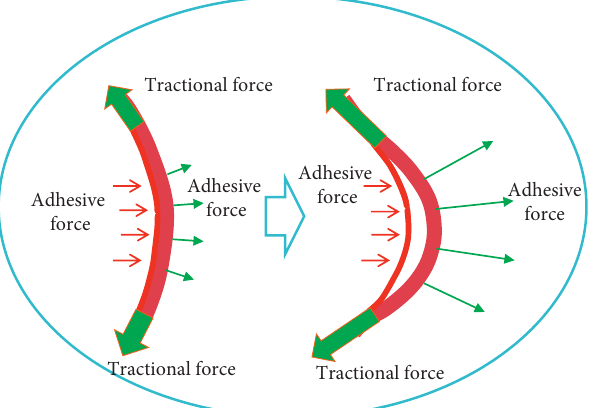
Figure 3: Possible mechanism of force in patients with myopic foveoschisis. The image on the left belongs to a nonmyopic patient. The image on the right belongs to a patient with myopic